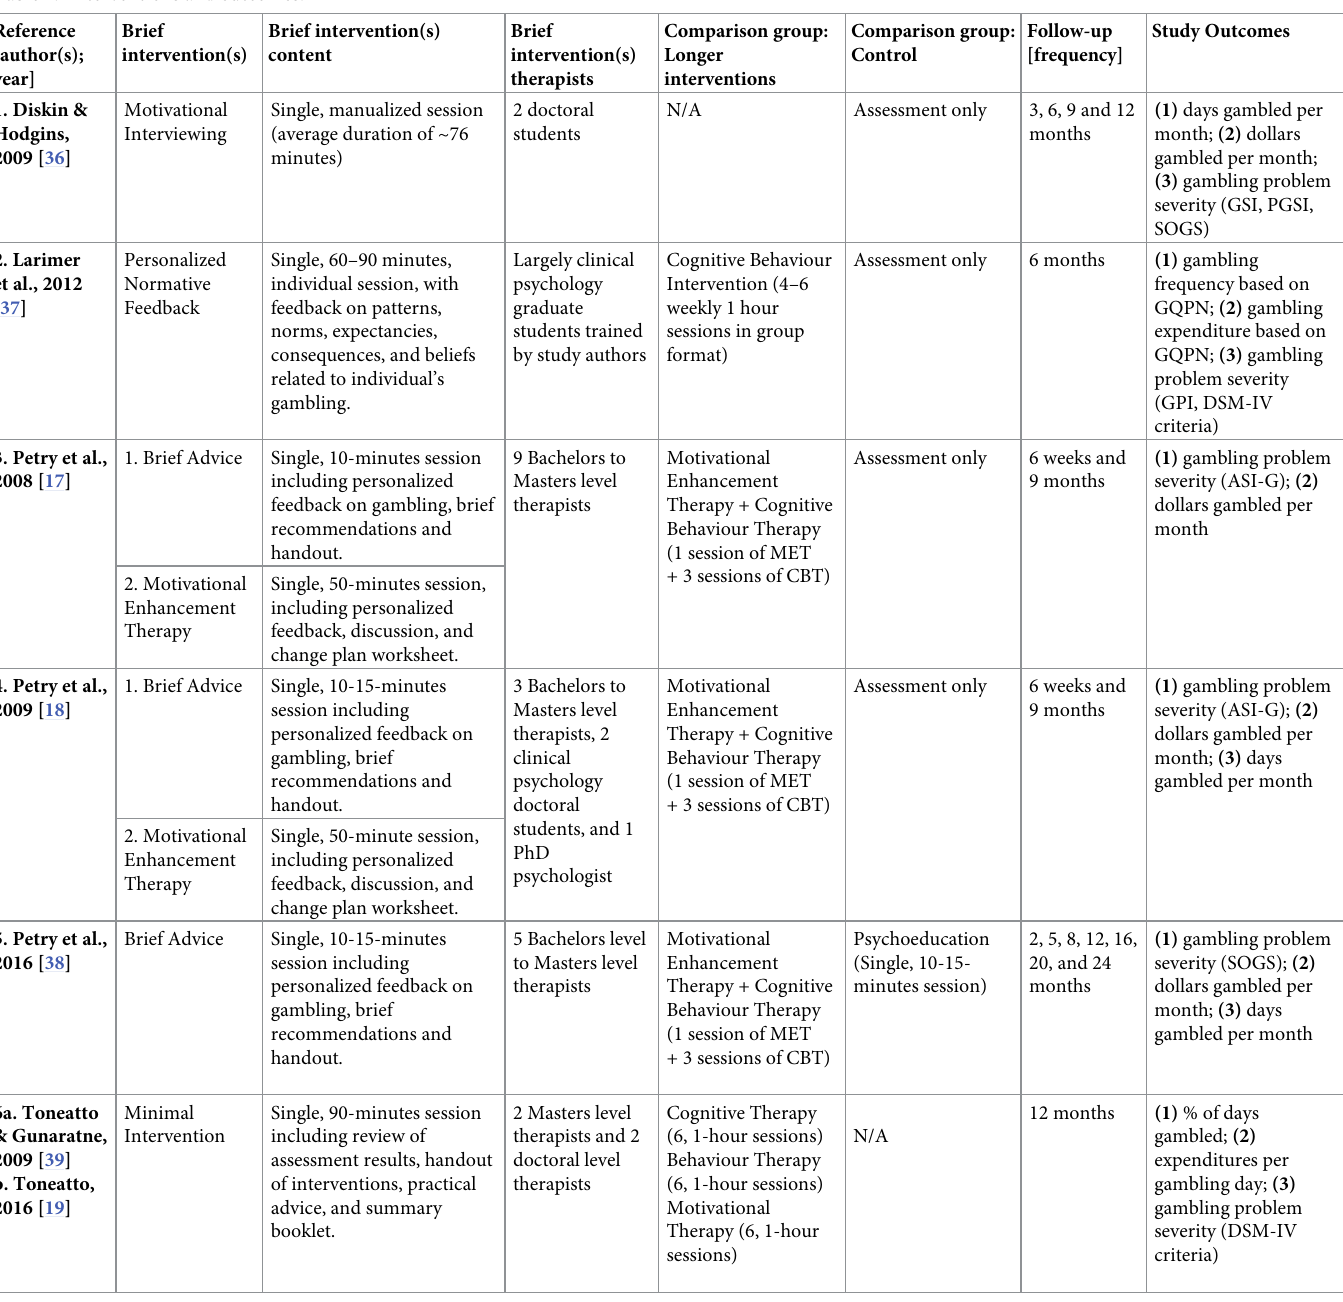
Table 2. Interventions and